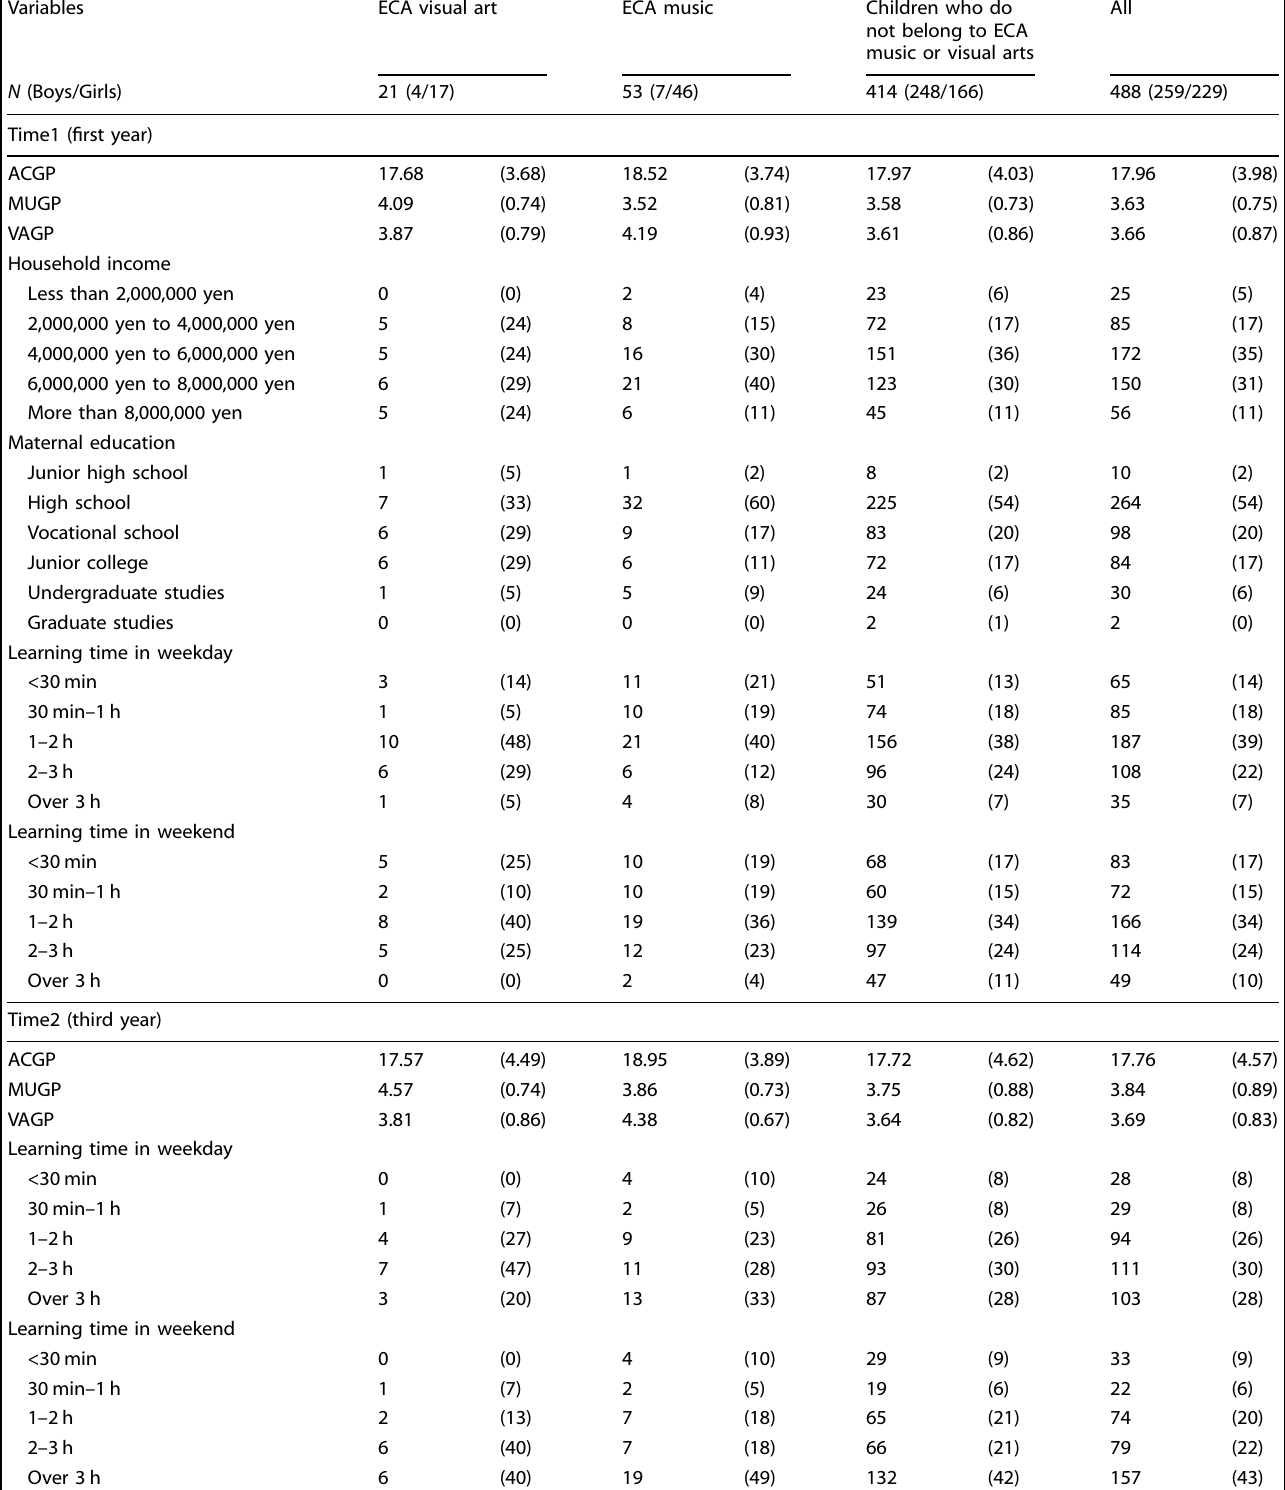
Table 2. Characteristics of the participating